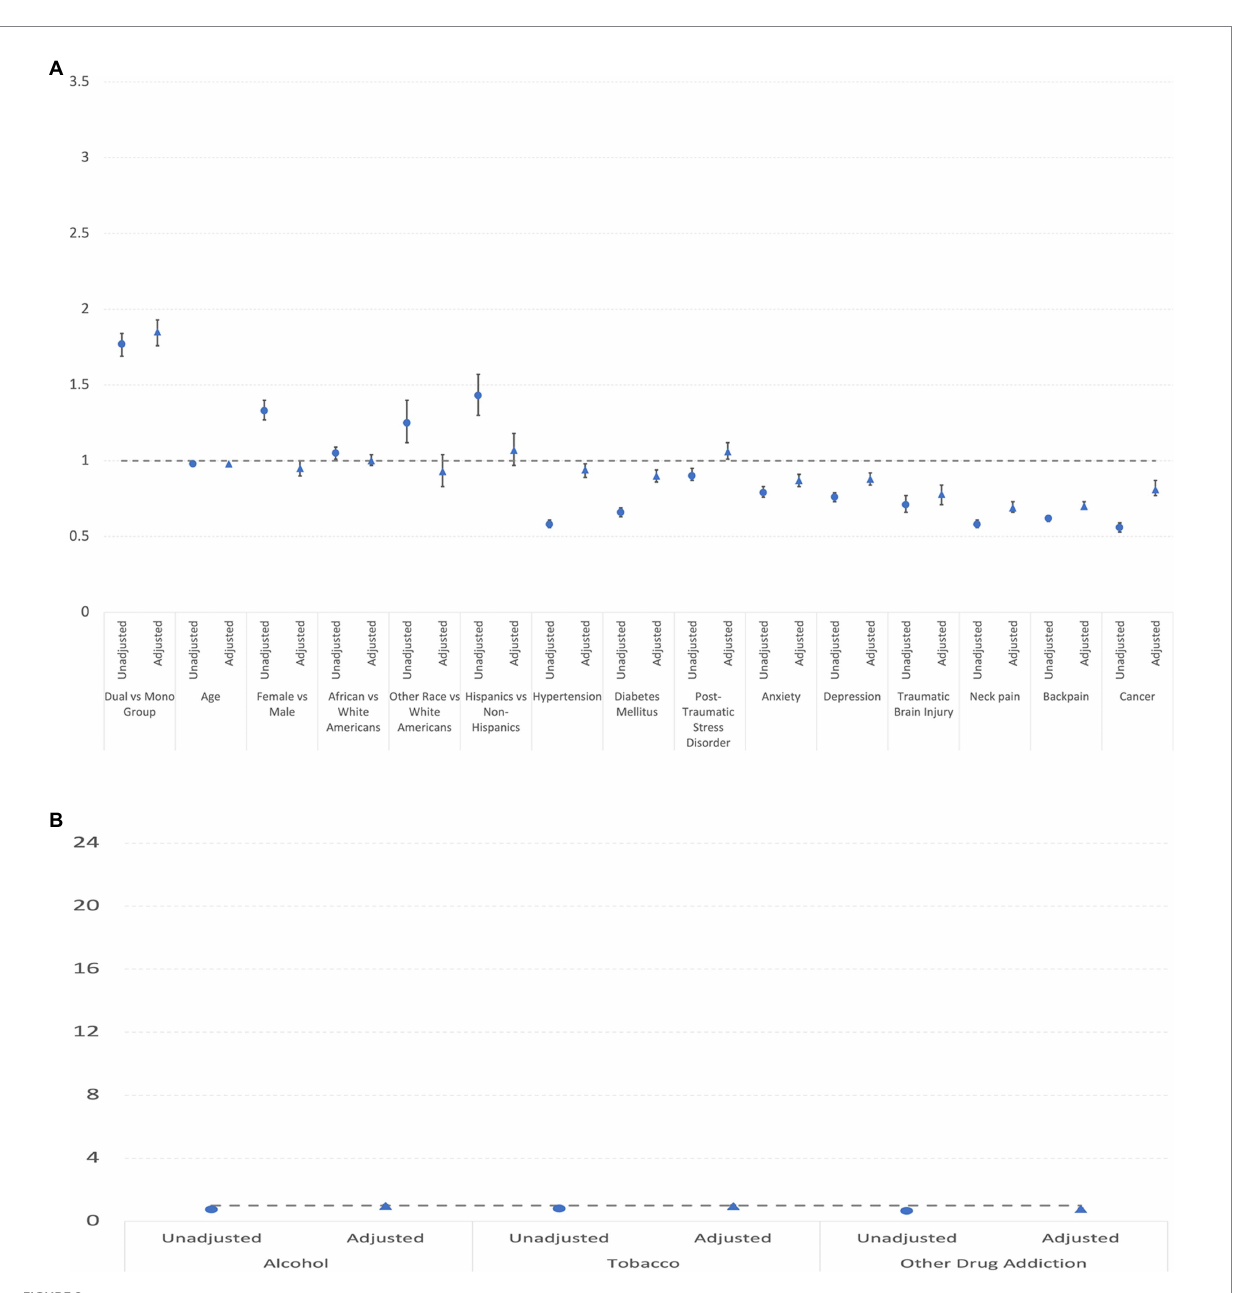
FIGURE 2 (A) Unadjusted and adjusted odds rations and confidence intervals of covariates (excluding addictions) for new opioid prescription. (B) Unadjusted and adjusted odds rations and confidence intervals of addiction covariates for new opioid